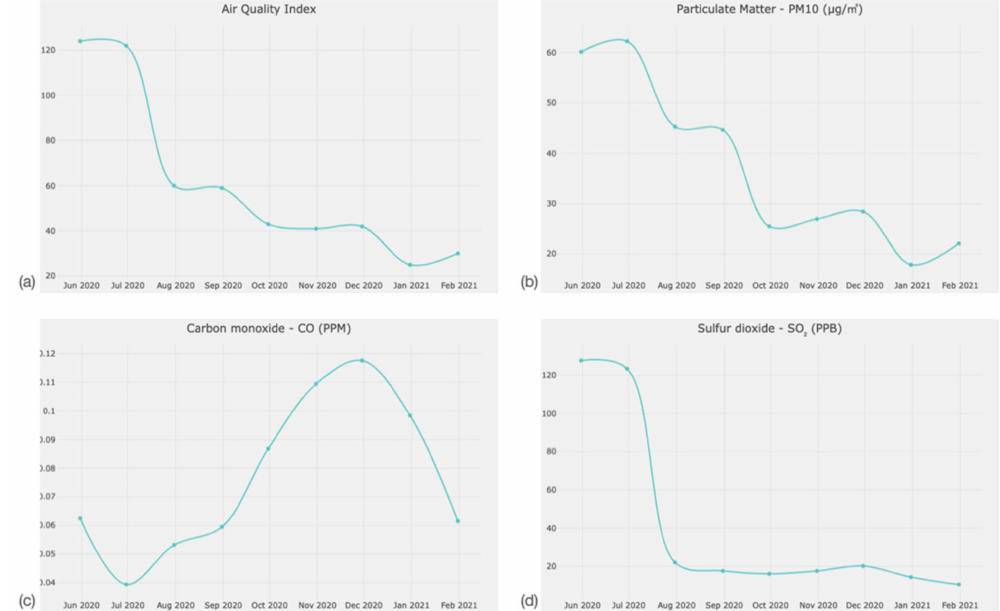
Figure 10. Monthly average in Santo Domingo of ( a ) air quality index, ( b ) PM 10, ( c ) carbon monoxide and ( d ) nitrogen dioxide as presented from the platform.